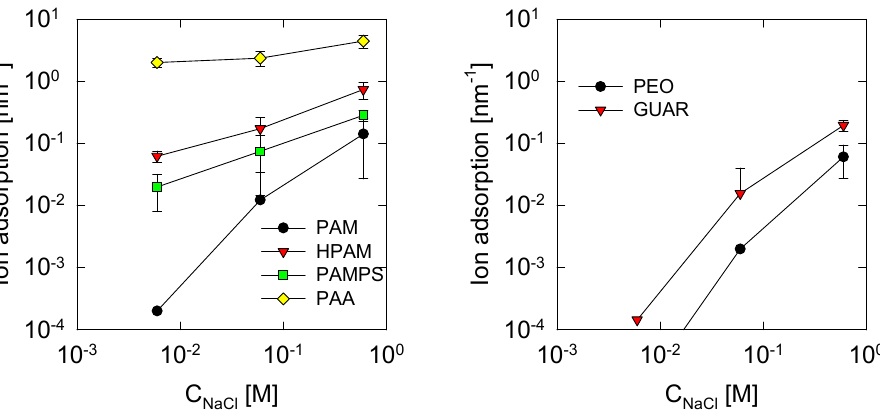
Figure 4. Na + ion adsorption per unit length of the studied polymer. Error bars for adsorptions less than 10 − 2 were omitted.